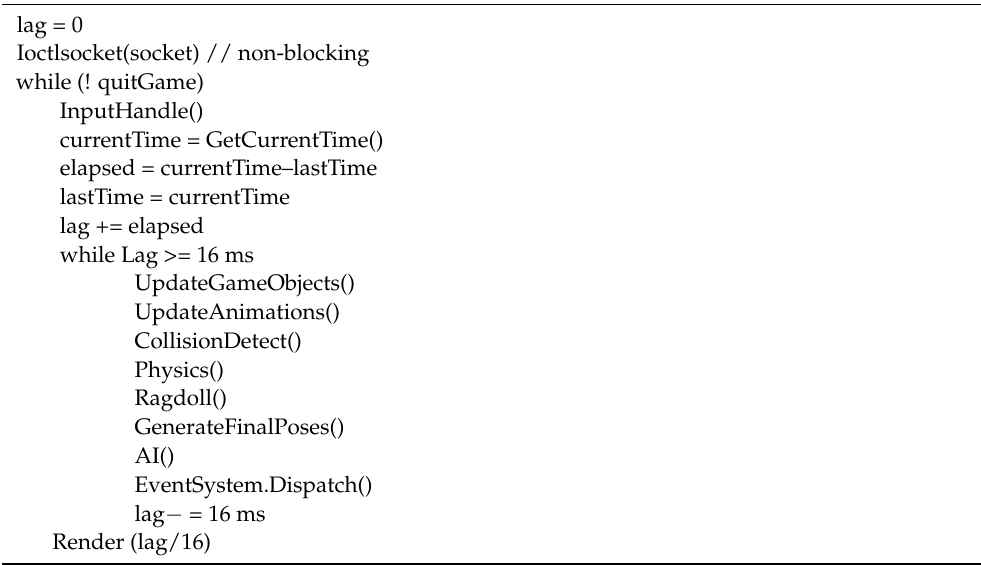
Algorithm 1: Main loop in a one-thread scenario.